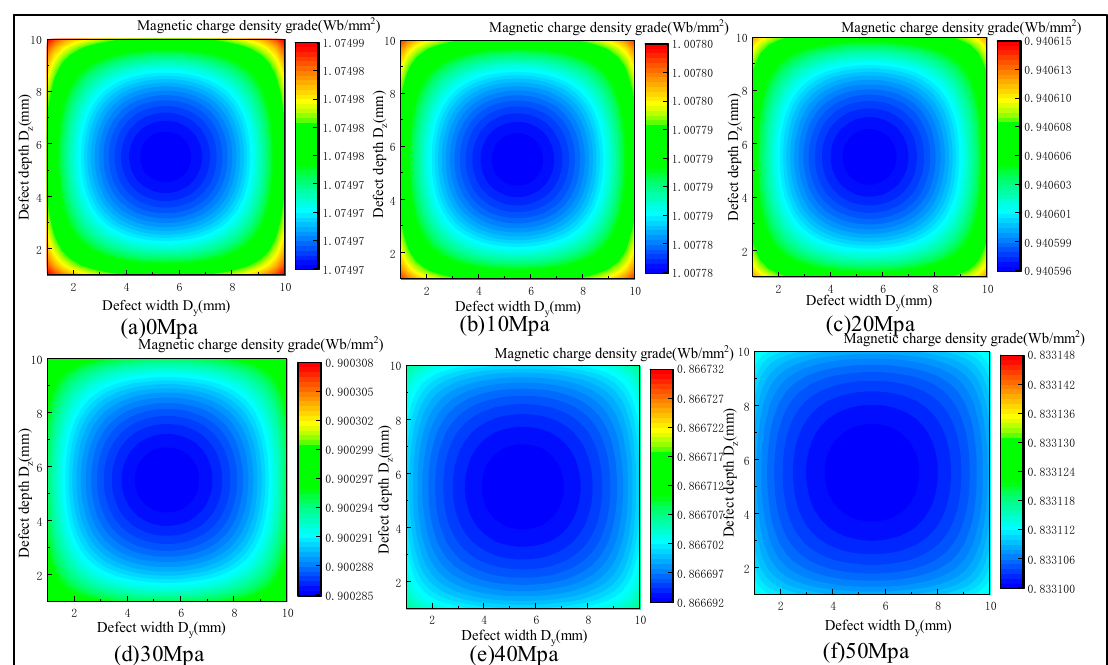
Figure 4. Distribution of magnetic charge density on the side wall of defects under stress. With the increase in the stress, the magnetic charge density on the side wall of the defect gradually decreased, and the overall magnetic charge presented a non-uniform distribution (Figure 4). The corresponding relationship between the stress and magnetic charge density is shown in Figure 5.